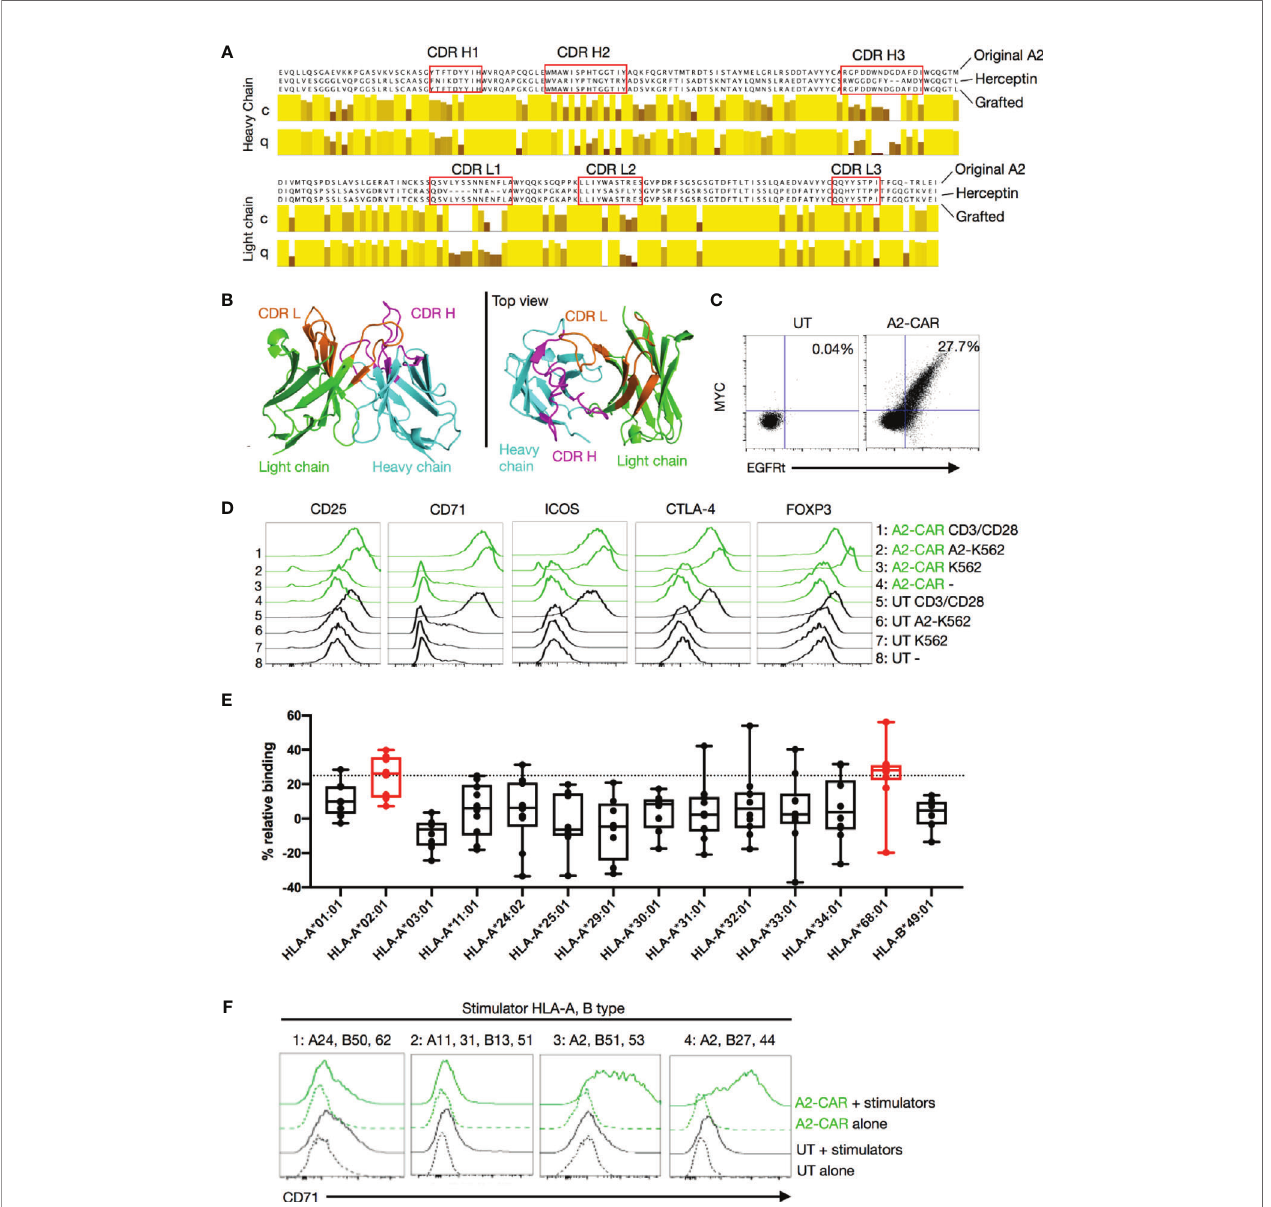
FIGURE 1 | Generation of a grafted A2-CAR. (A) Grafting strategy comparing the original V H and V L chain sequences of the SN607D8 hybridoma and of the Herceptin (trastuzumab) 4D5 scaffold. The grafted amino acid sequences are shown. The sequences of SN607D8 and 4D5 HER2 were aligned using the software Jalview and the level of conservation (C) and quality (Q) of each amino acid between SN607D8 and 4D5 sequences were compared. Conservation re fl ects similarity of the physicochemical properties of amino acid residues. Identical residues are shown as light-yellow columns and residues with more dissimilar physicochemical properties are marked with darker column colors. Quality measures the likelihood of observing a mutation in any particular amino acid residue position (38). CDRs were predicted using Paratome (29). (B) The conformation of the grafted antibody was predicted with ABodyBuilder (39) and displayed using PyMOL Molecular Graphics System (DeLano Scienti fi c, San Carlos, CA). (C) EGFRt and MYC-tag expression on Day 6 of culture of human Tregs transduced with the grafted A2-CAR-2A-EGFRt lentivirus. (D) On Day 9, A2-CAR Tregs were cultured for another 48 hours alone, with anti-CD3/CD28 beads, or with irradiated (4000 rad) parental A2 – K562 or A2- expressing K562 cells. CD25, CD71, ICOS, CTLA-4, and FOXP3 expression were analyzed thereafter using fl ow cytometry. (E) OneLambda FlowPRA Single HLA Antigen bead panels FL1HD01 and FL1HD02. Percentage relative binding of A2-CAR Tregs to each HLA allele was calculated as described in the Materials and Methods section. Plotted averages of at least 5 independent experiments. Red coloring indicates HLA allele beads surpassing the 25% binding threshold to be considered binders. (F) On Day 9, A2-CAR or UT T cells were cultured for another 48 hours alone or with dissociated islet cells from 4 allogeneic donors. Expression of CD71 was analyzed thereafter using fl ow cytometry. HLA-A and -B alleles expressed by the 4 allogeneic donors are indicated above the histograms. For donors 1, 3, and 4, A2-CAR and UT Tregs were used in the assay and for donor 2, A2-CAR and UT CD4 + Tconv cells are used. Results are a summary of 4 independent experiments using T cells from unrelated healthy donors. scFv, single-chain variable fragment; CDR, complementarity-de fi ning region; A2, HLA-A2; UT, untransduced; Tconv, conventional T cells